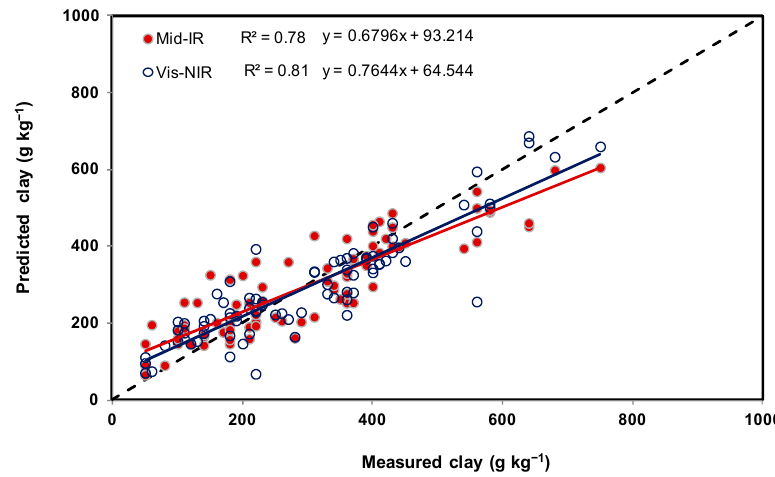
examples in accordance with Tables 3 and 4.